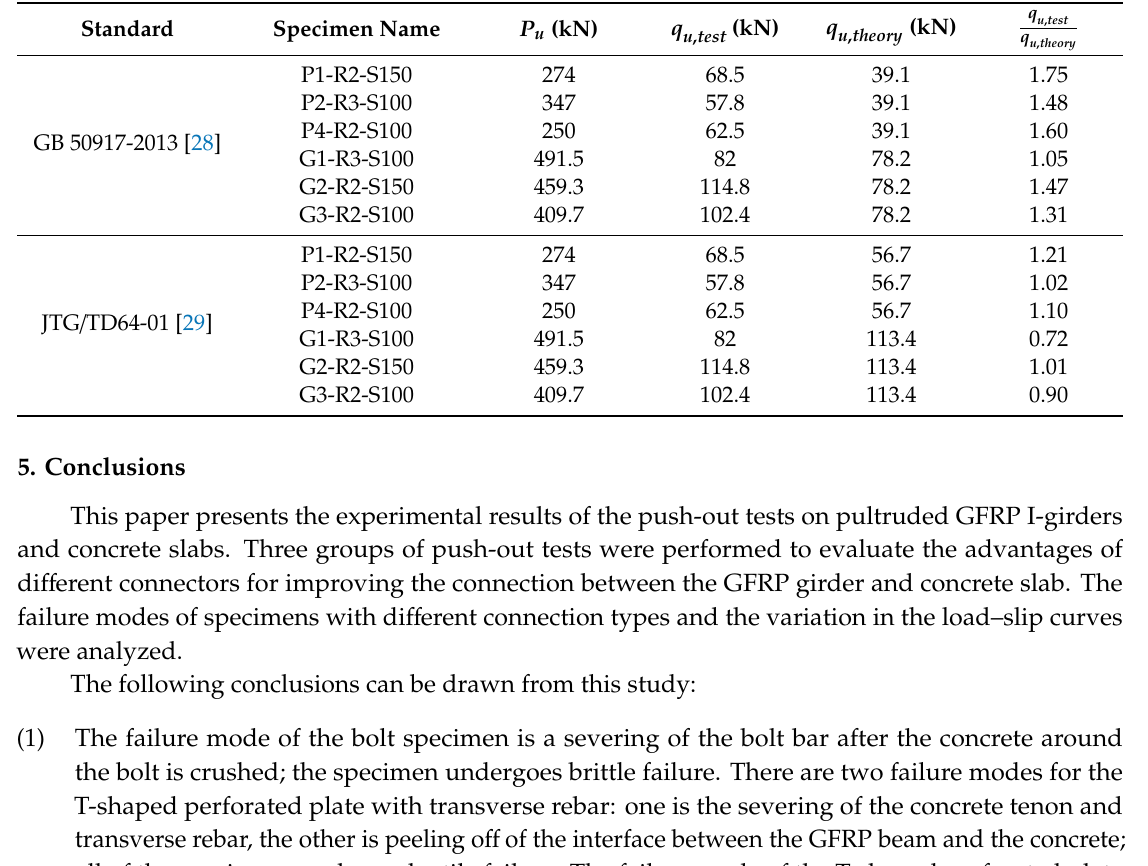
Table 5. Test values and calculation values of perforated connectors in push out